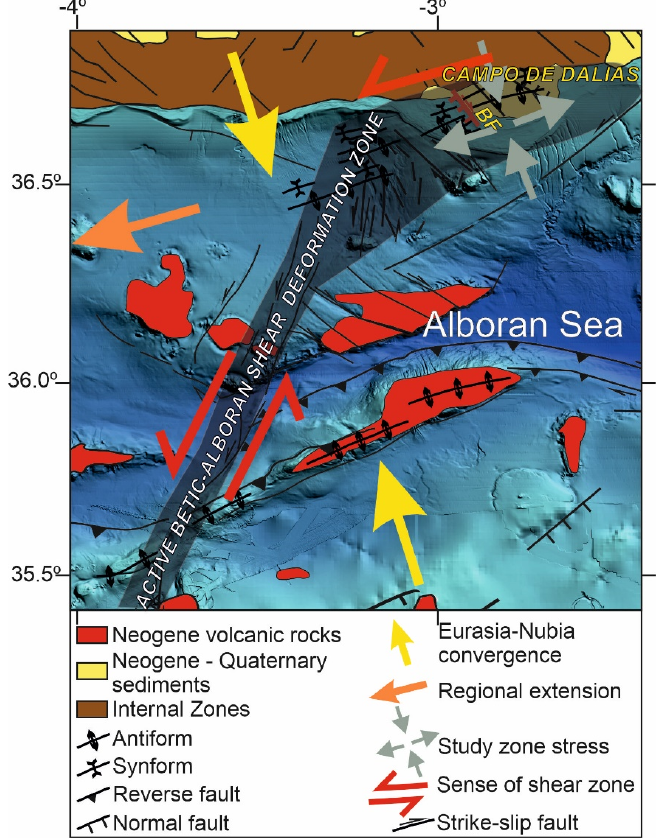
Figure 6. Tectonic sketch of the central Alboran Sea, relating deformation of the Campo de Dalias to the northeast tip of the active Betic-Alboran shear zone. BF: Balanegra Fault.